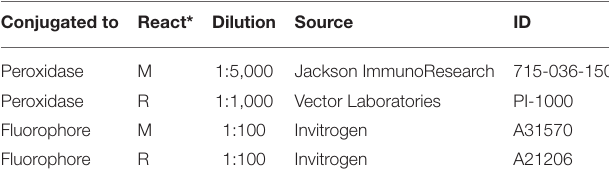
TABLE 1C | Secondary